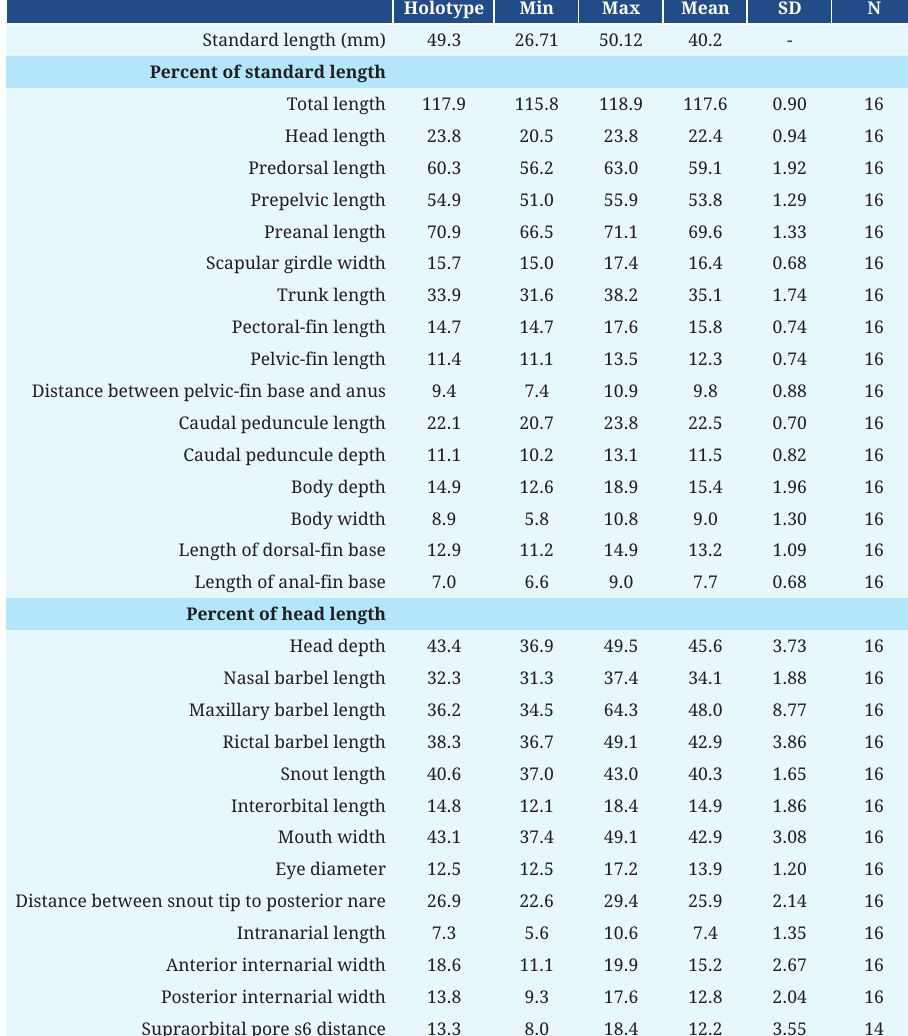
TABLE 6 | Morphometric data of Scleronema mate , new species (data of holotype included in the range). N = number of specimens; SD = standard